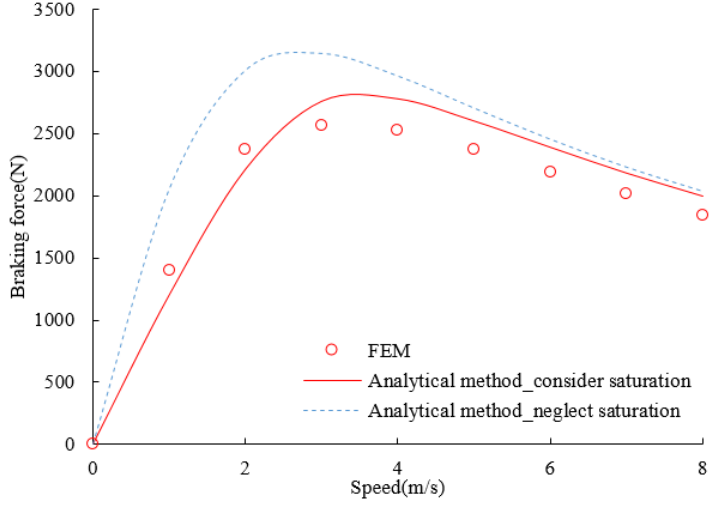
Figure 7. Braking force characteristic.